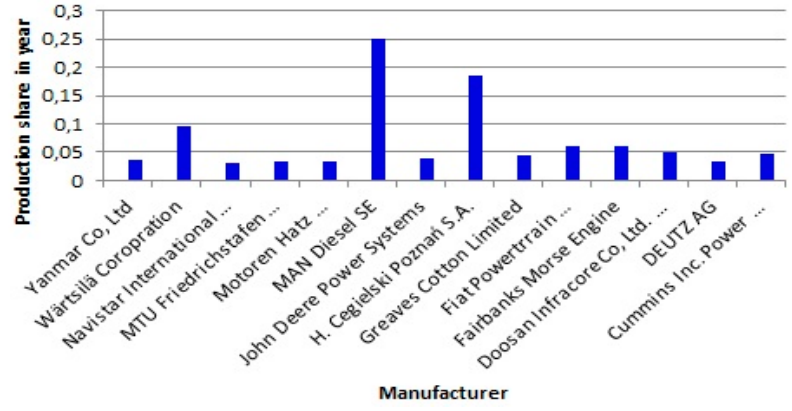
Figure 1. Comparison marine diesel engines with a capacity above 0.5 MW ordered worldwide in 2010.